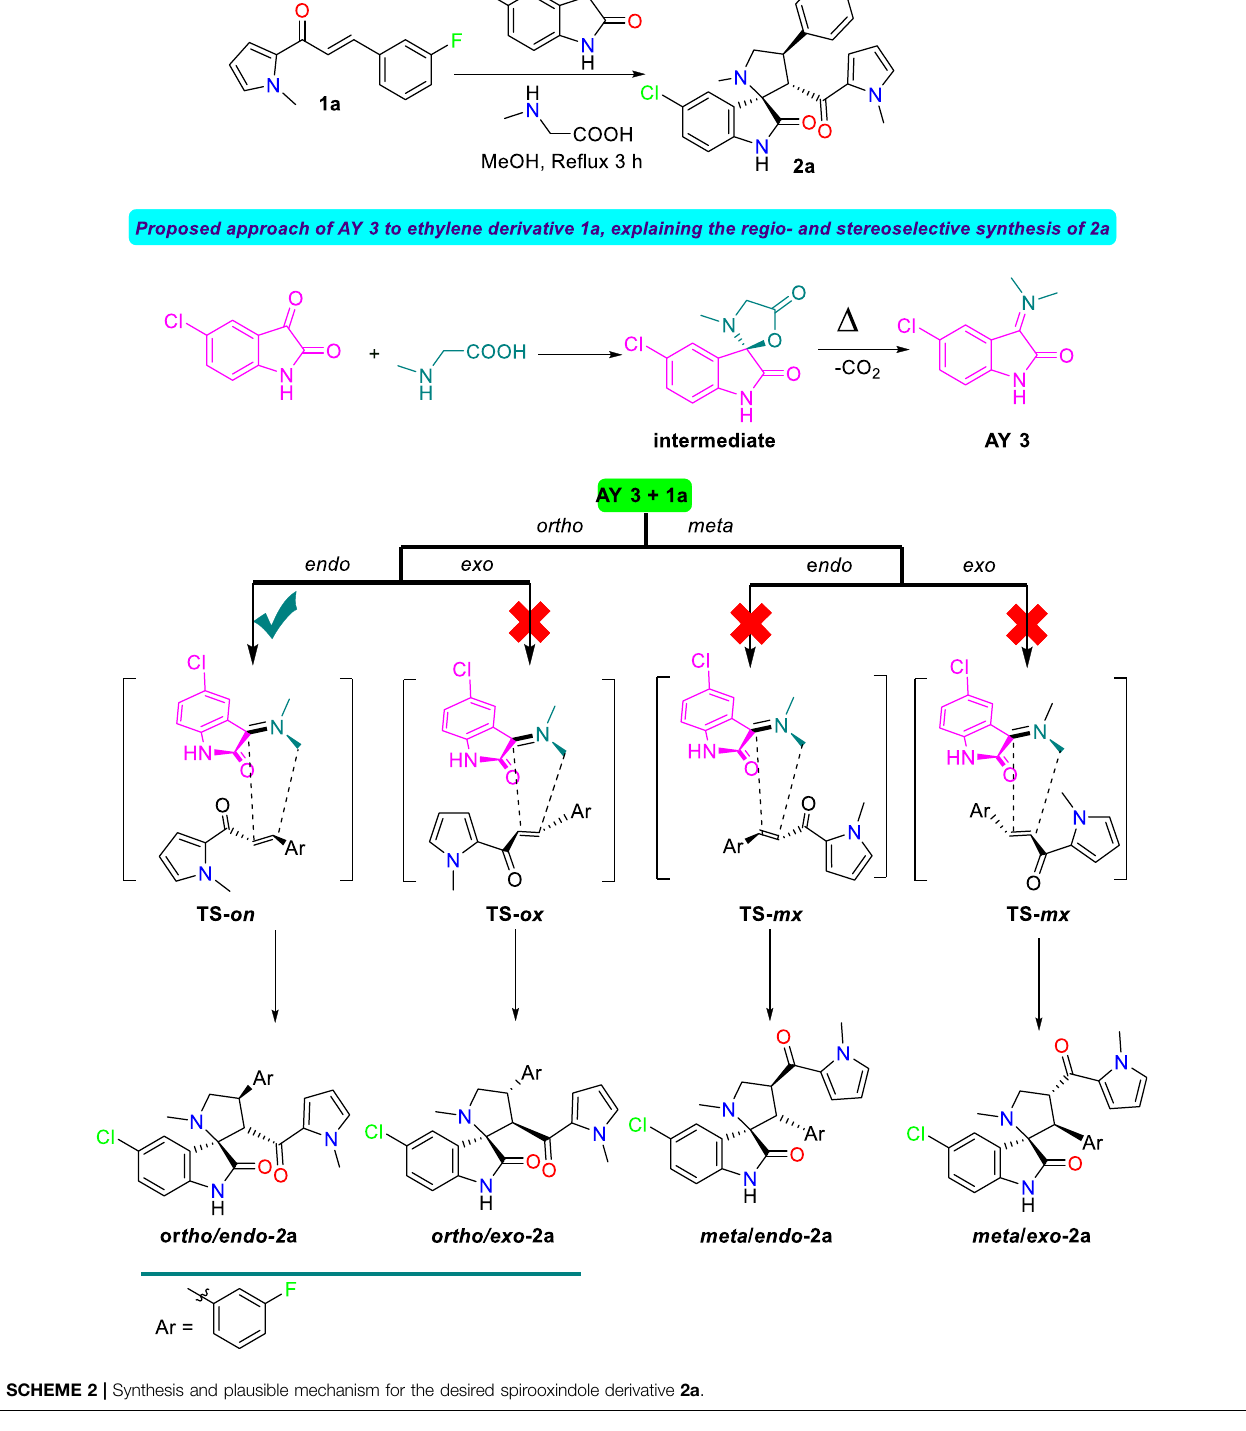
via carbonyl spacer inspired by marinopyrrole; a natural marine product that disrupt Bcl2 family functions by multiple mechanisms ranging from direct inhibition to downregulation